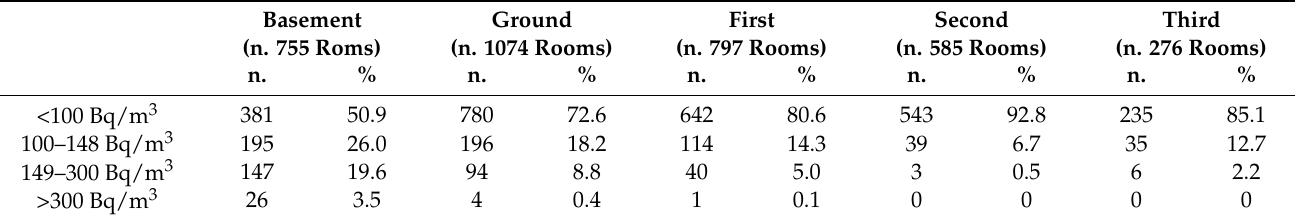
Table 3. Levels of radon for each floor, in relation to the World Health Organization (WHO)